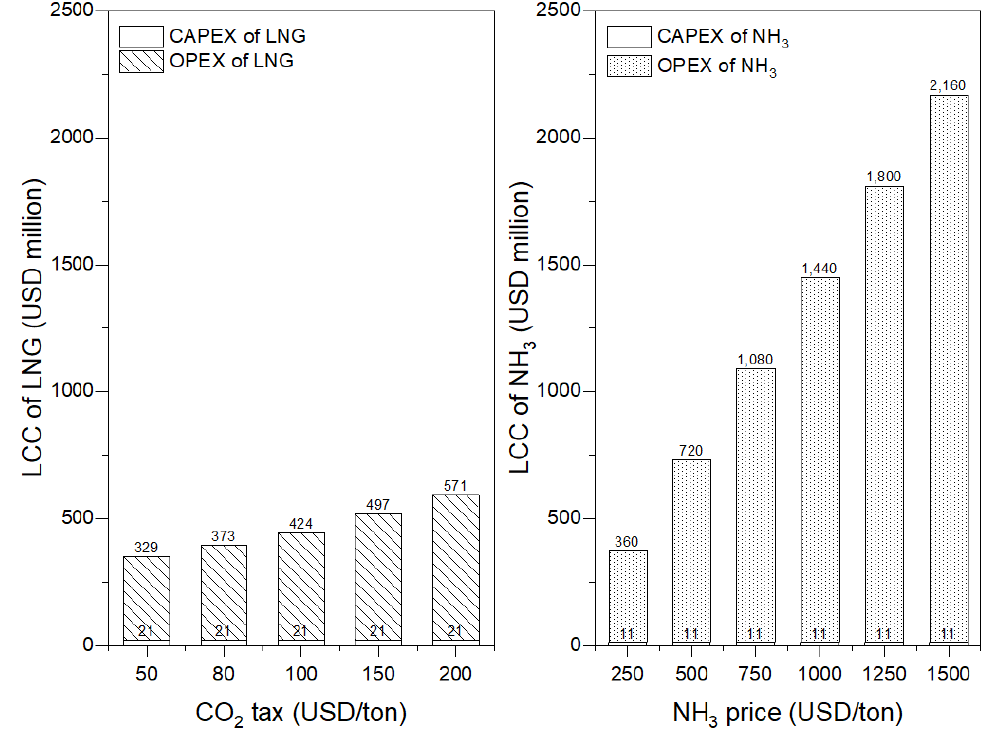
Figure 11. LCC of LNG and NH 3 for the carbon tax and NH 3 price.